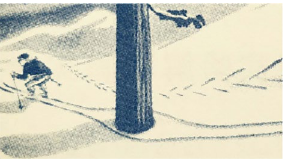
Figure 1. Coming from Charles Addams, The New Yorker,